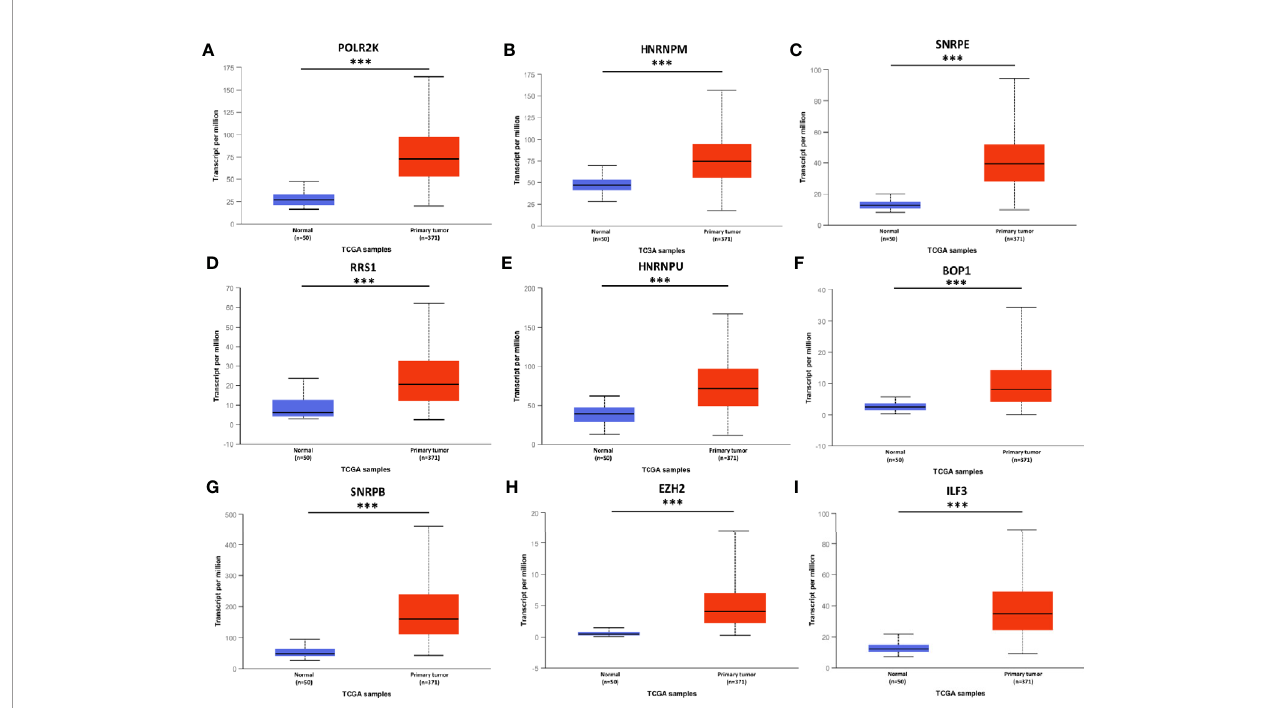
FIGURE 3 | mRNA expression of hub genes in HCC tissues and adjacent normal tissues. All these hub genes were highly expressed in tumor tissues (A – I) . *** P < 0.001.